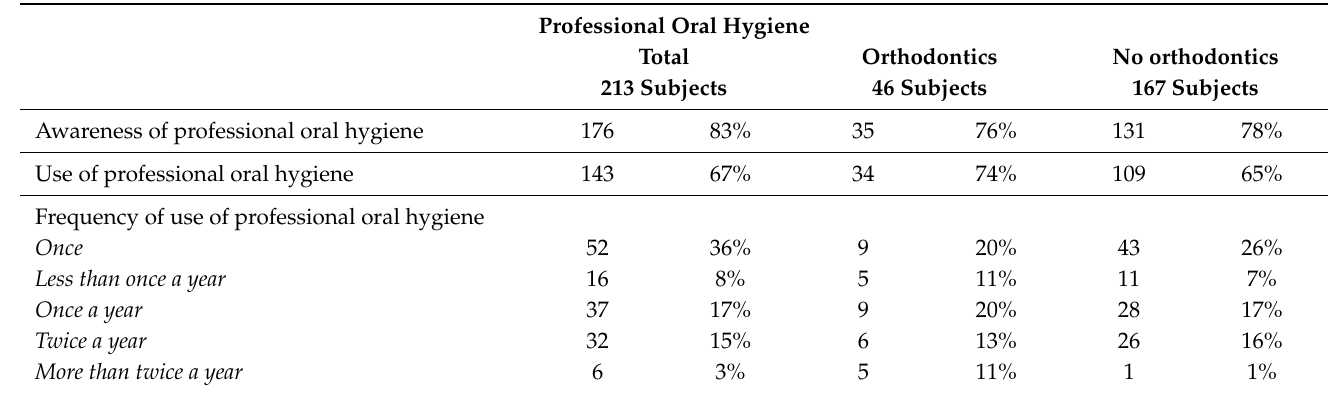
Table 3. Data obtained about professional oral hygiene.